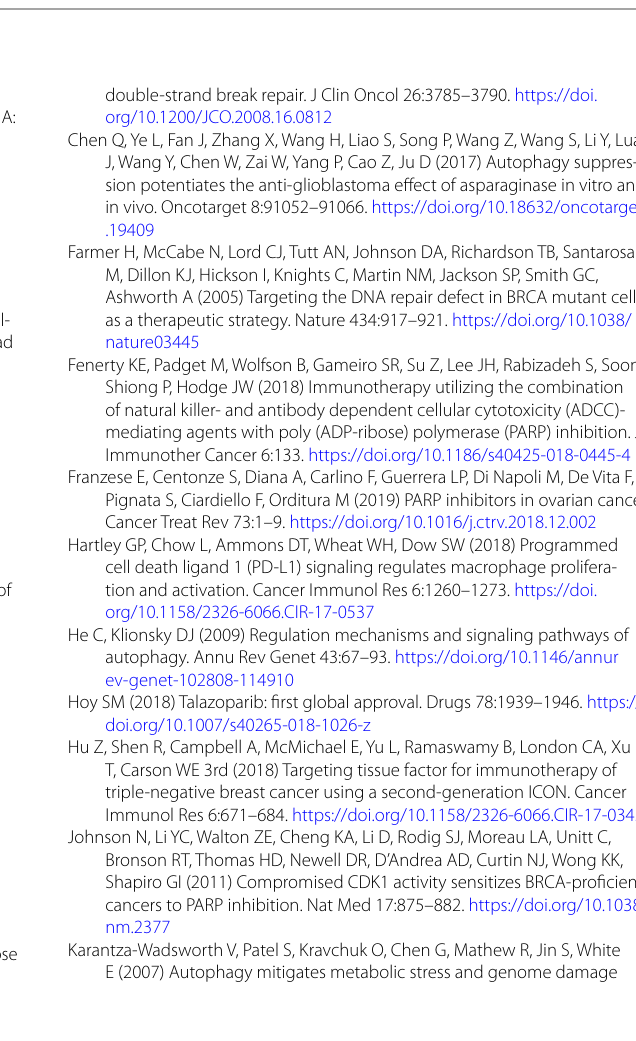
SD. Each point indicated an independent value from one mouse ±